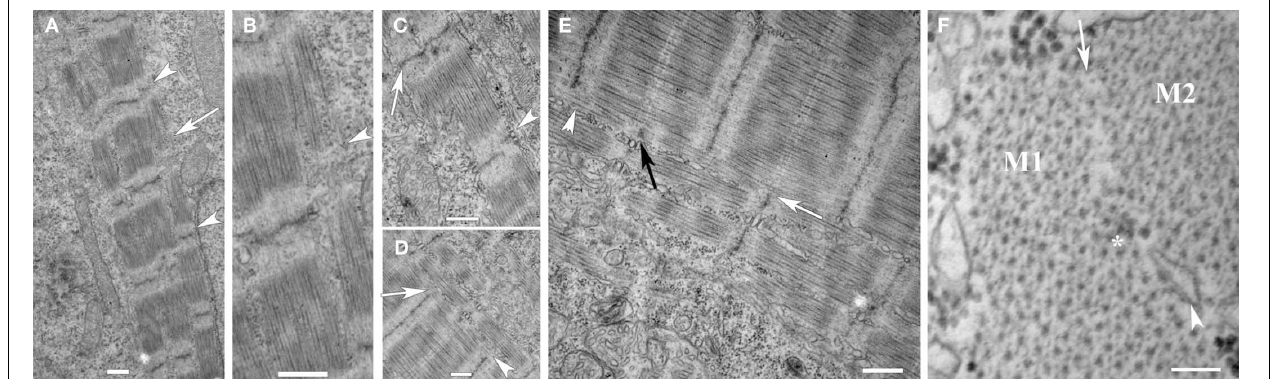
FIGURE 5 | Lateral integration of new myofibrils involves coordinate remodeling of the sarcomeres, the cellular cytoskeleton and the surrounding membranes. (A) New skeletal myofibrils in a 20hpf zebrafish embryo undergoing lateral fusion show progressive alignment at the level of the Z disks (arrowheads). Note the paucity of myofilaments in the intervening region between the Z disk involved in the active lateral incorporation (arrow) with intact sarcomeres on either end of the remodeling sarcomere. (B) A higher magnification of the image in (A) demonstrating the area of remodeling with interruption of the myosin filaments (arrowhead). (C) Newly assembled sarcomeres demonstrating recent alignment of the Z disks in register one end of the sarcomere (arrow) and misalignment at the other end (arrowhead). (D) Lateral integration of myofibrils with loss of defined